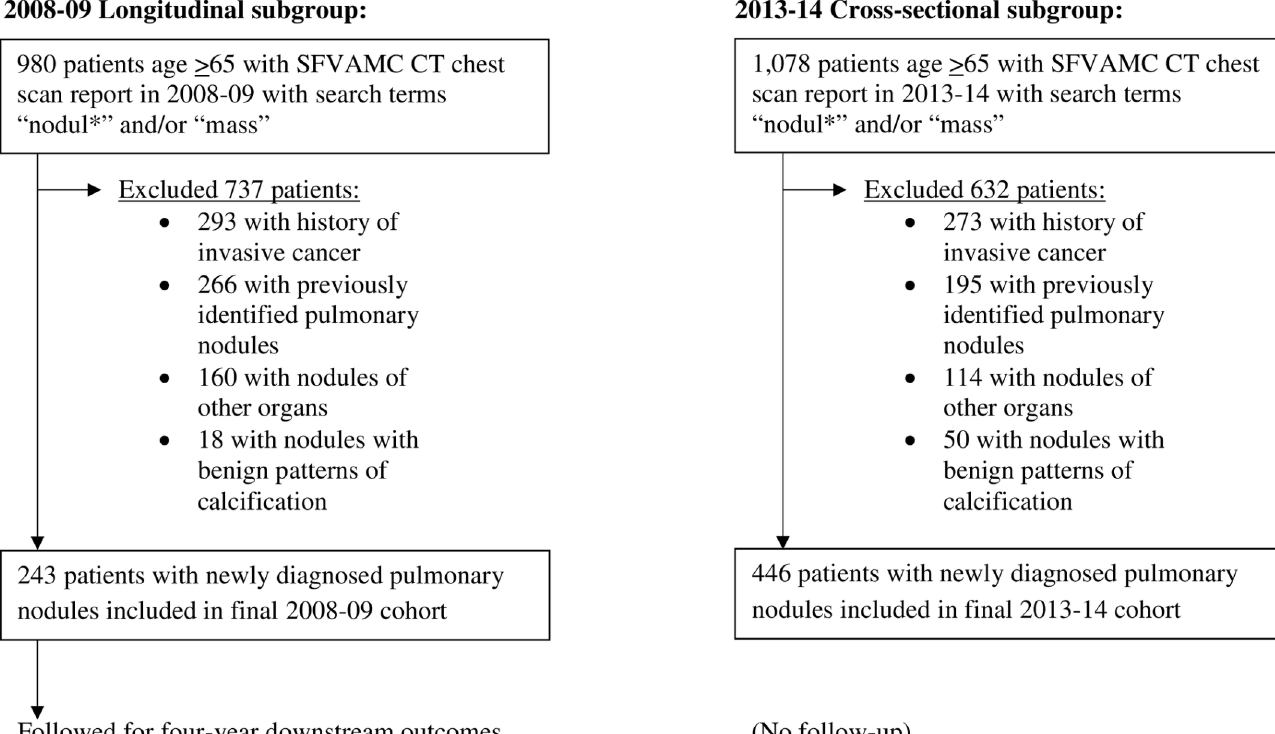
PLOS ONE | https://doi.org/10.1371/journal.pone.0200496 July 25,